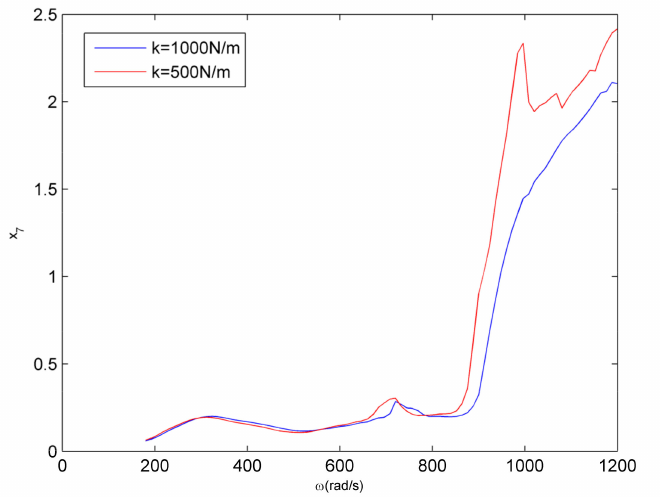
Figure 19. Comparison of the amplitude–frequency